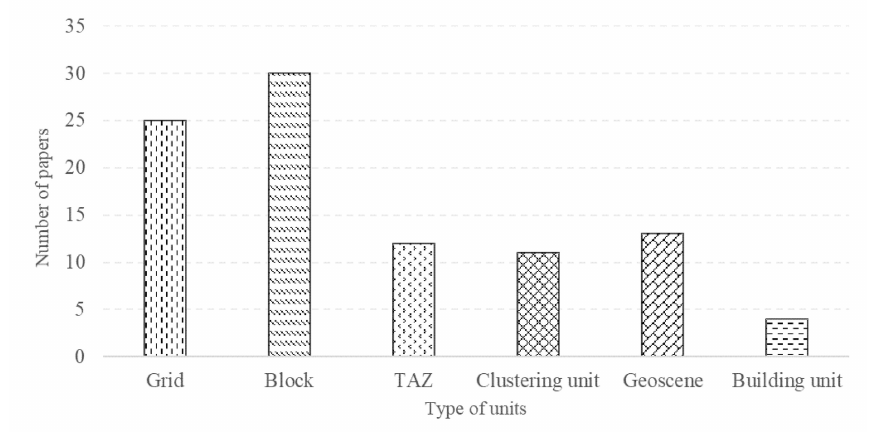
Figure 5. Statistics of the publications using the six units of the urban functional